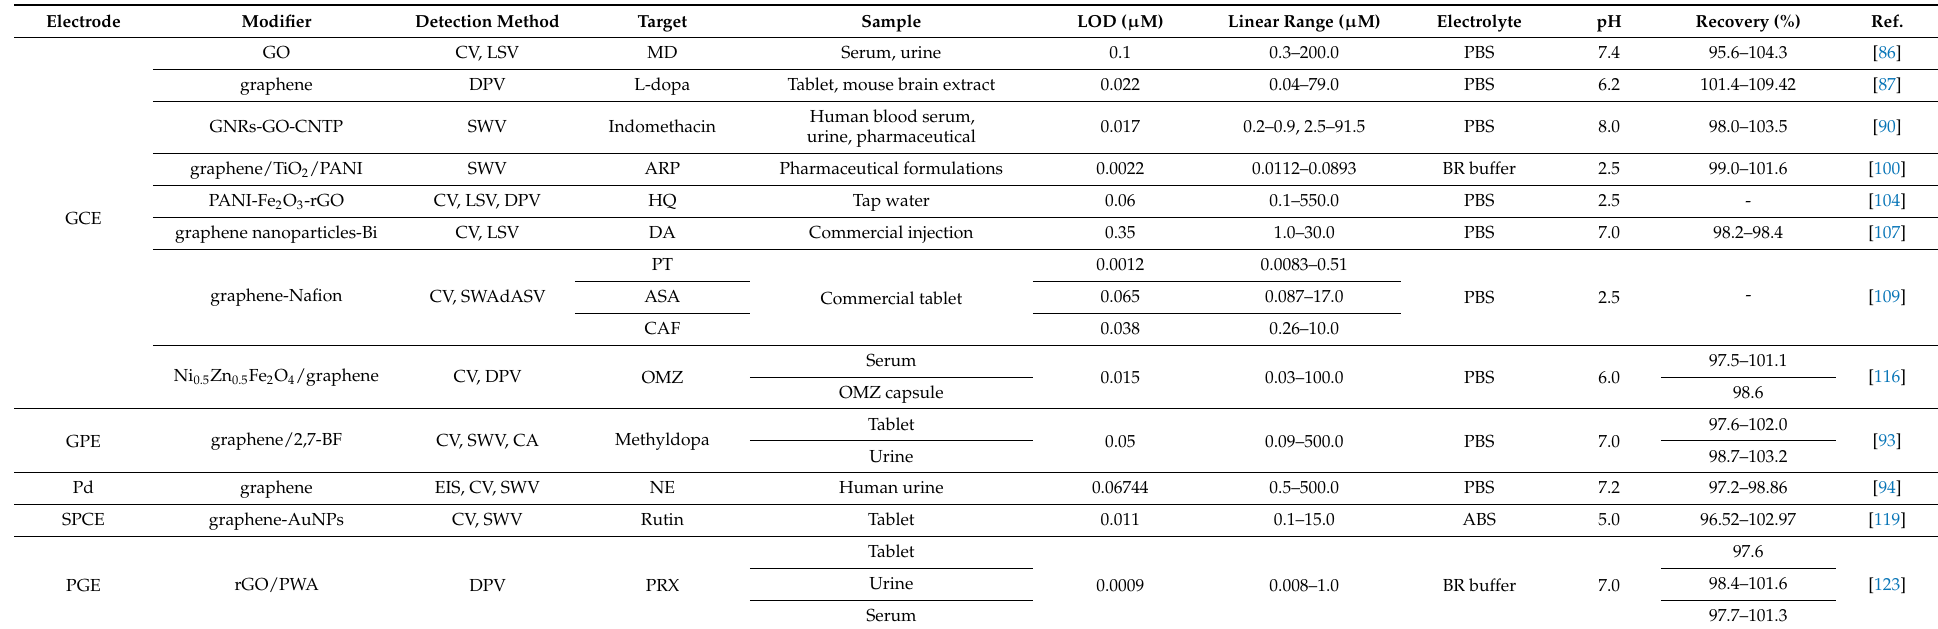
Table 3. Summary of graphene utilization for pharmaceutical